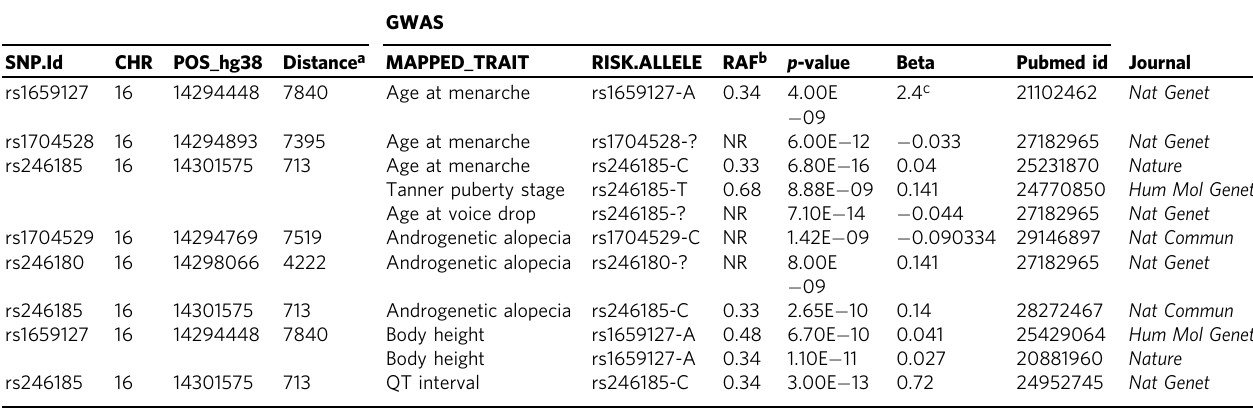
Table 1 Summary of genome-wide association studies reported SNPs in lincNORS